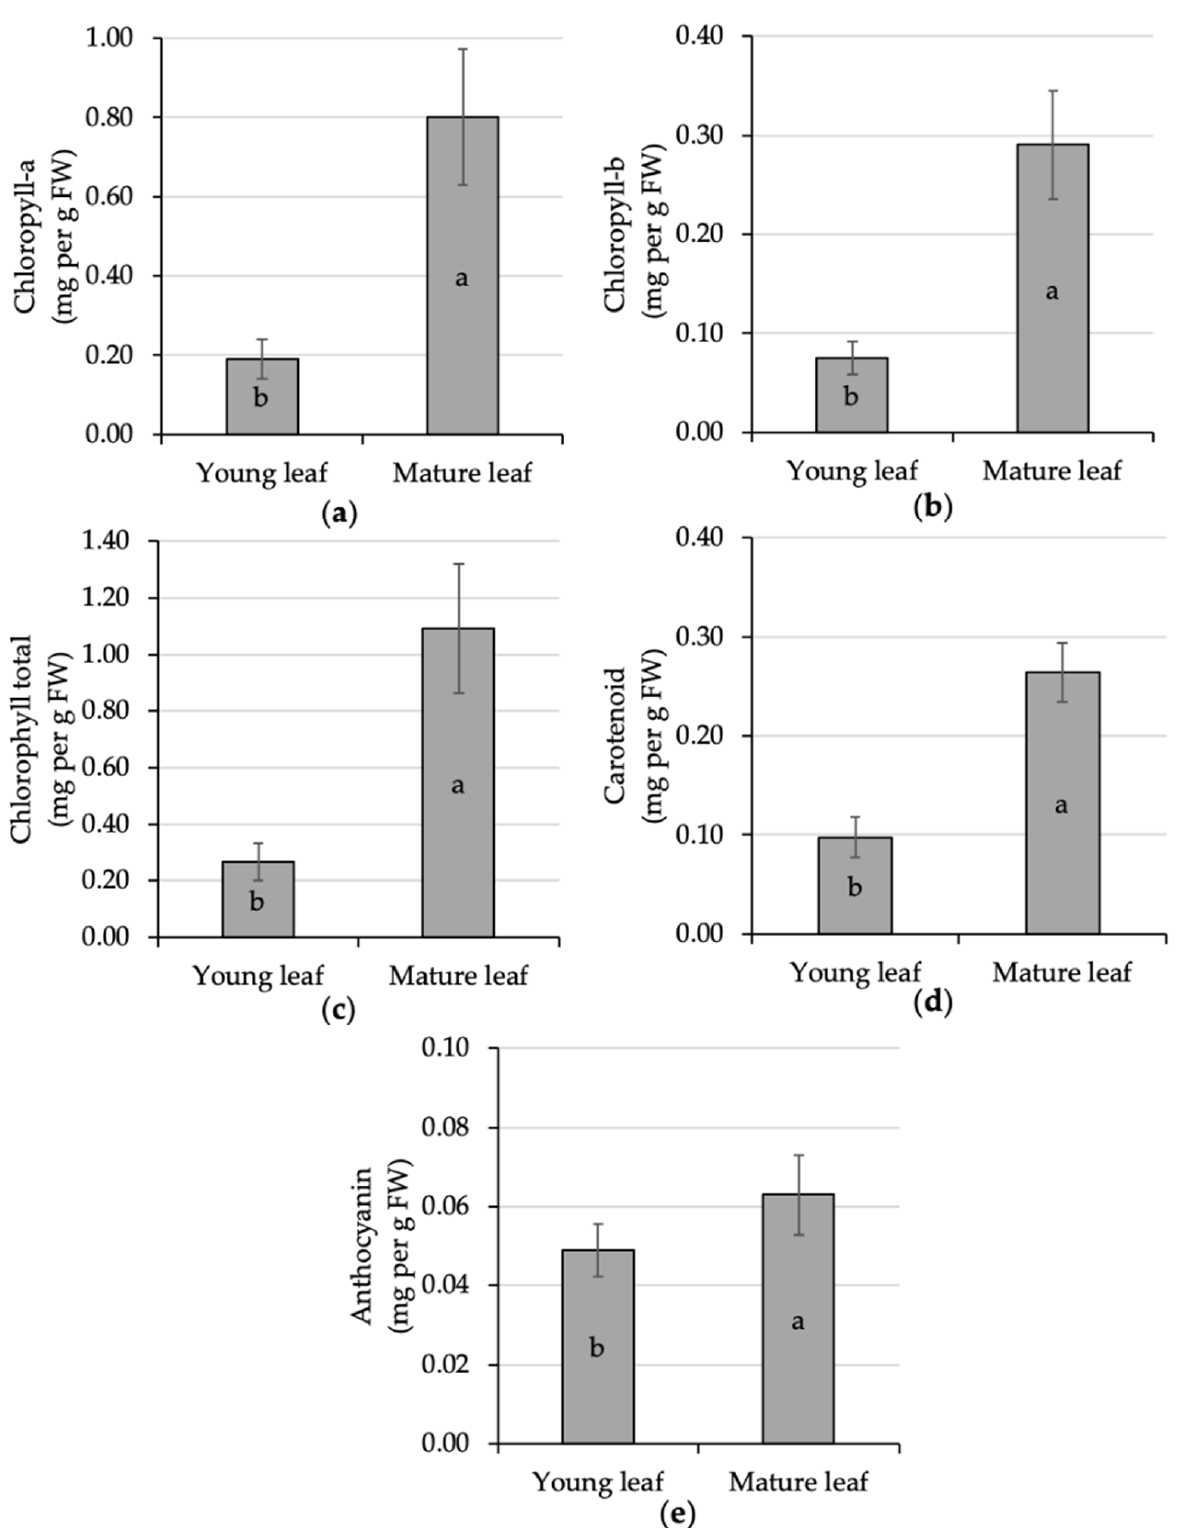
Figure 4. Comparative analysis of the pigment content of young and mature kaffir lime leaves;